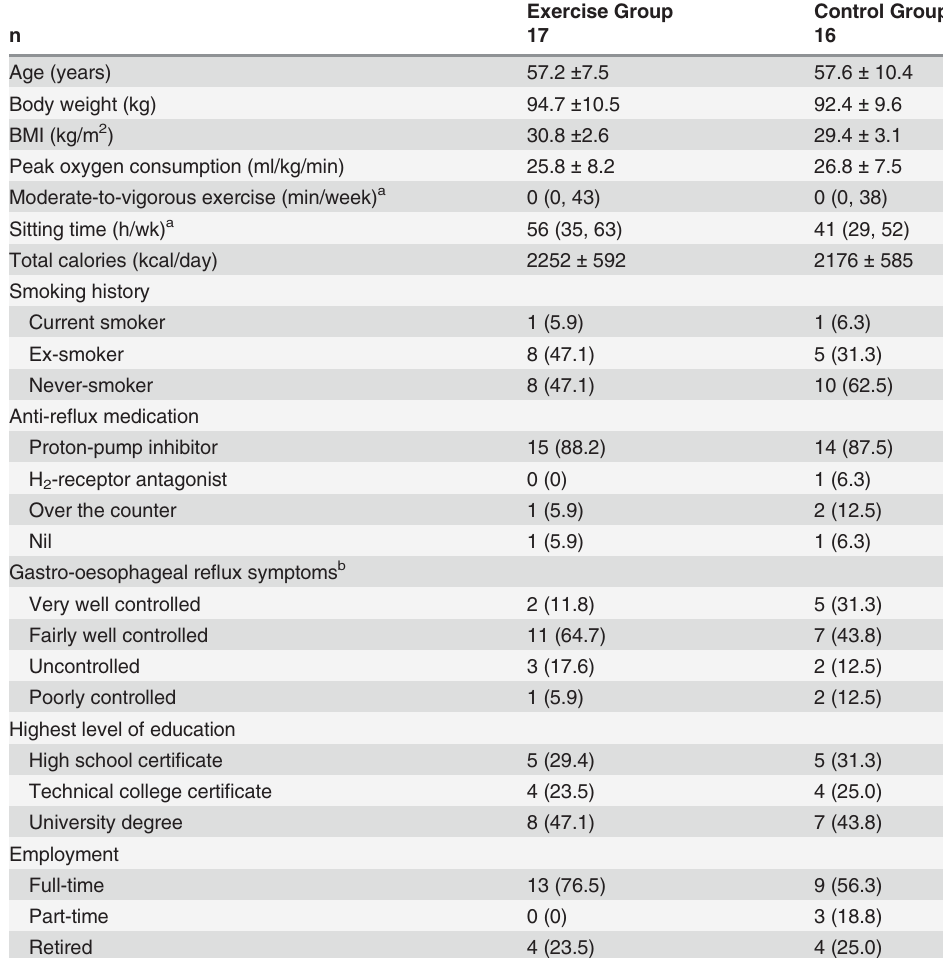
Table 1. Baseline characteristics of participants allocated to the exercise and control